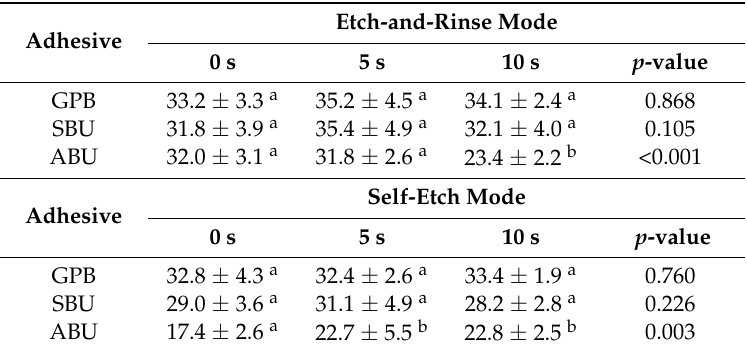
Table 1. Microtensile bond strength values (MPa) means and standard deviation for all experimental groups.